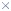
Transcription levels of selected genes related to molting and endocrine-mediated pathways in D. magna exposed to 2 mg/L of BTR (×), 5MeBTR (●) and 5ClBTR (▲) for 4-, 8- and 21d.(A) ecr, (B) usp, (C) cyp18a1, (D) hr3, (E) ftz-f1, (F) kr-h1, (G) famt, (H) met, (I) src. Gene transcription values are indicated in log2FC from qRT-PCR measurements. * indicates a significant difference from the corresponding control (p<0.05).